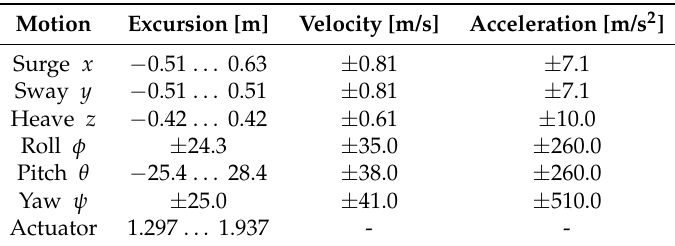
Table 3. System performance of the motion